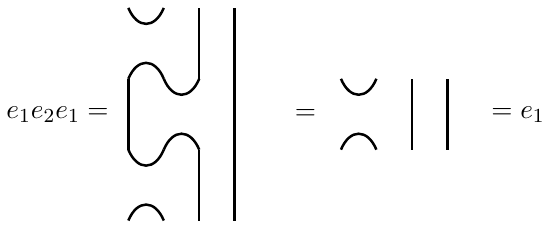
Figure 19 . Graphical interpretation of e 1 e 2 e 1 = e 1 .